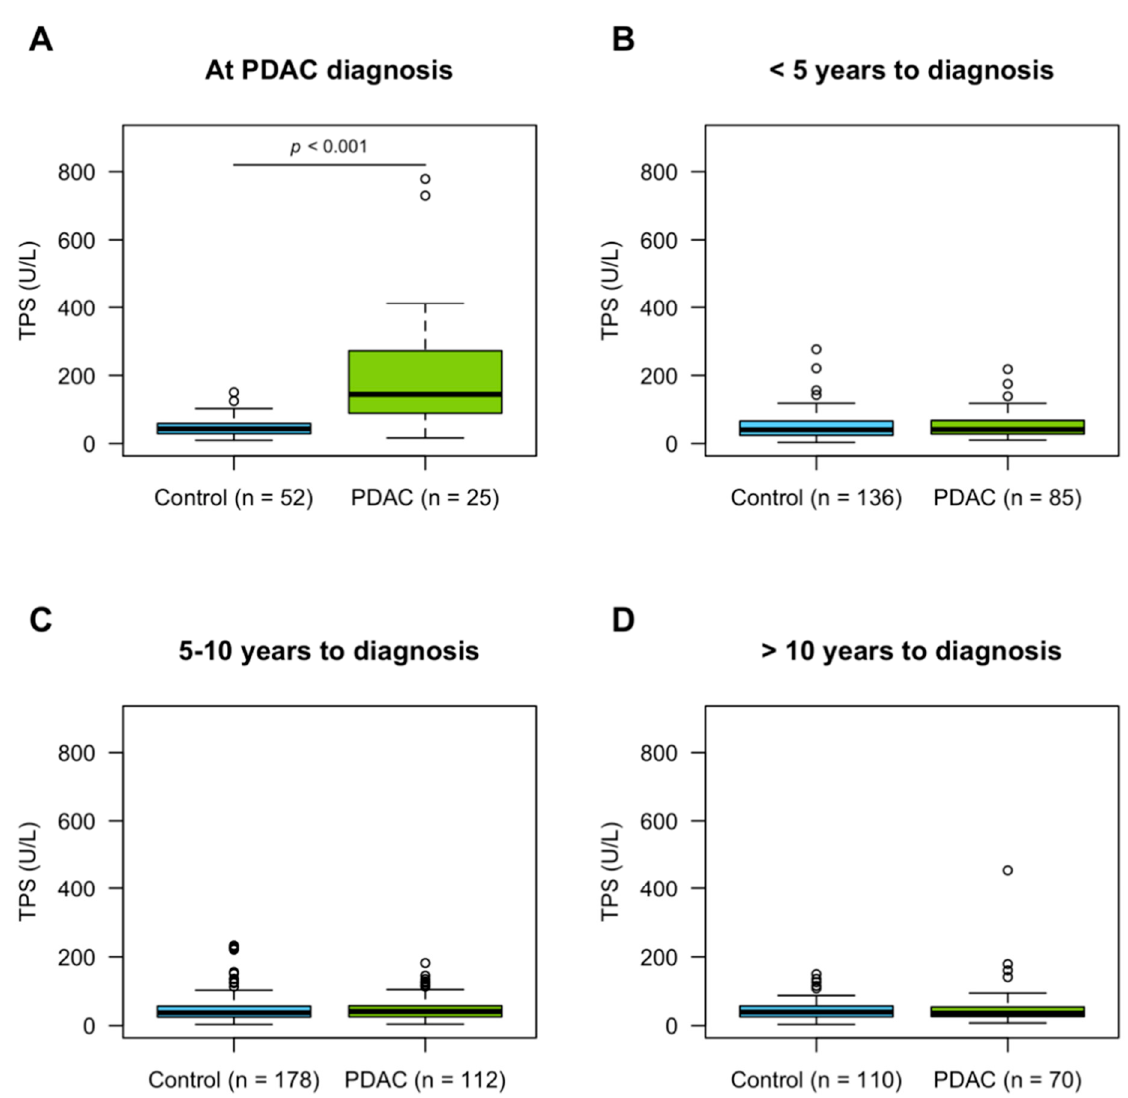
Figure 2. TPS levels in plasma samples stratified by time to PDAC diagnosis. The TPS levels were compared between cases and controls ( A ) at diagnosis ( p -value from logistic regression model adjusted for age), ( B ) <5 years, ( C ) 5–10 years, and ( D ) >10 years prior to diagnosis.